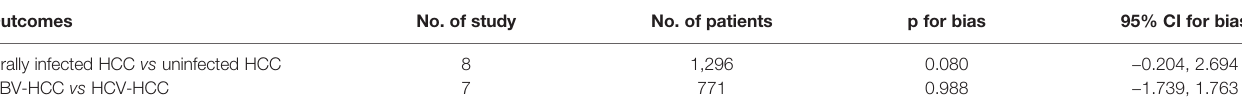
CI, con fi dence interval; HCC, hepatocellular carcinoma; HBV, hepatitis B virus; HCV, hepatitis C virus.